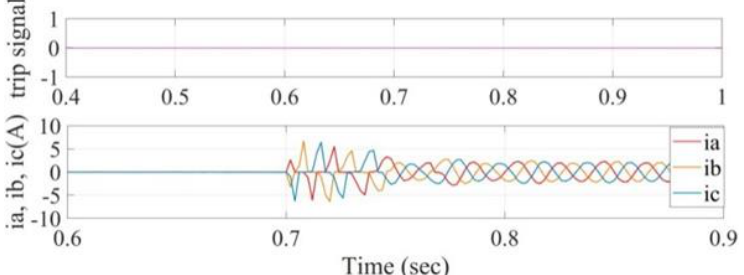
Figure 27. Stator currents’ signals and trip signal waveforms for healthy starting condition of an inductive motor.